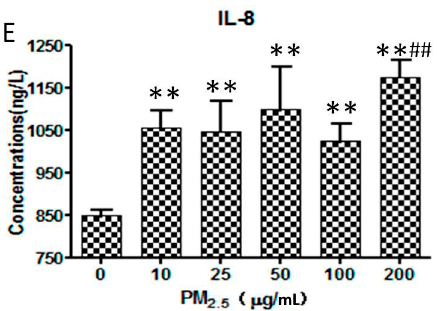
Figure 4. Levels of Granulocyte-macrophage Colony Stimulating Factor (GM-CSF) ( A ); Thymic Stromal Lymphopoietin (TSLP) ( B ); Tumor Necrosis Factor- α (TNF- α ) ( C ); Interleukin-1 α (IL-1 α ) ( D ); and Interleukin-8 (IL-8) ( E ) in HaCaT cells after being exposed to fine particles for 24 h. In each figure, the exposed doses from left to right are 0, 10, 25, 50, 100, and 200 µ g/mL. ** There were significant differences ( p < 0.01) between the exposed group and the control. ## There were significant differences ( p < 0.01) between the group and the former group. (ANOVA statistics was used to calculate the statistical difference between the exposed group and the control and between the exposed group and its adjacent former group. Each analysis was carried out three times independently).